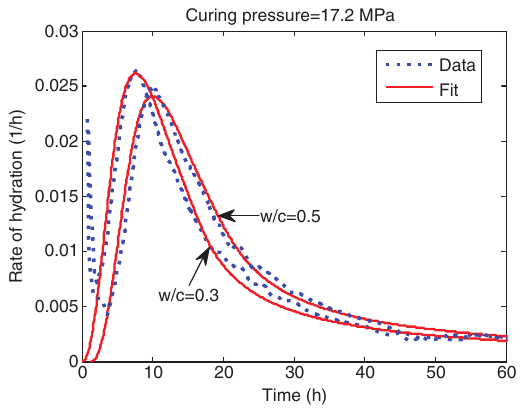
Figure 7: Representative model fit to experimental data of Class H cement prepared with different w/c ratios (ambient curing